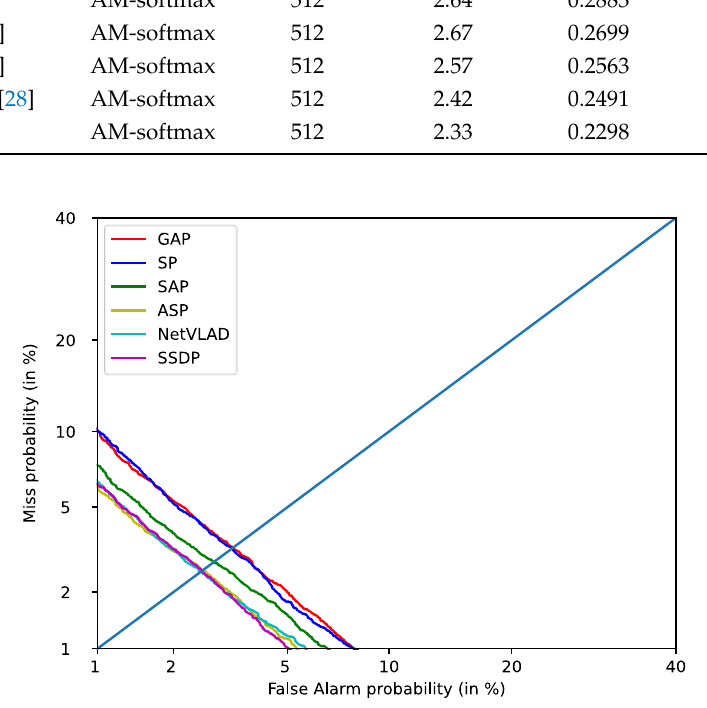
Figure 4. DET curve of aggregation models on Voxceleb1-O. Table 5. Results of aggregation models on Voxceleb1-O.